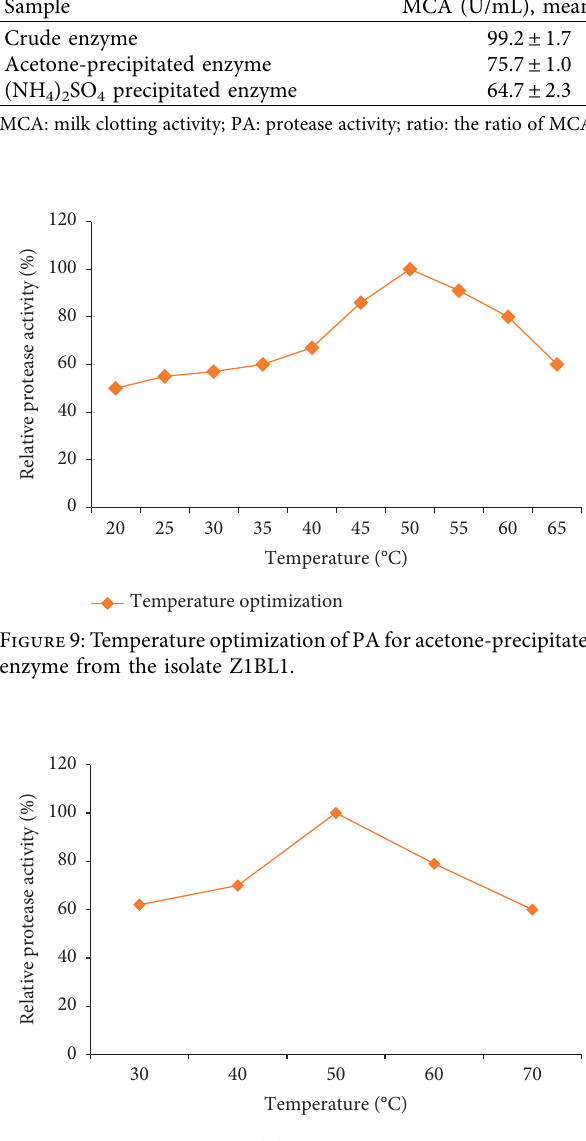
Table 5: Protease activity of the crude enzyme and partially purified enzyme from the isolate Z1BL1. Sample